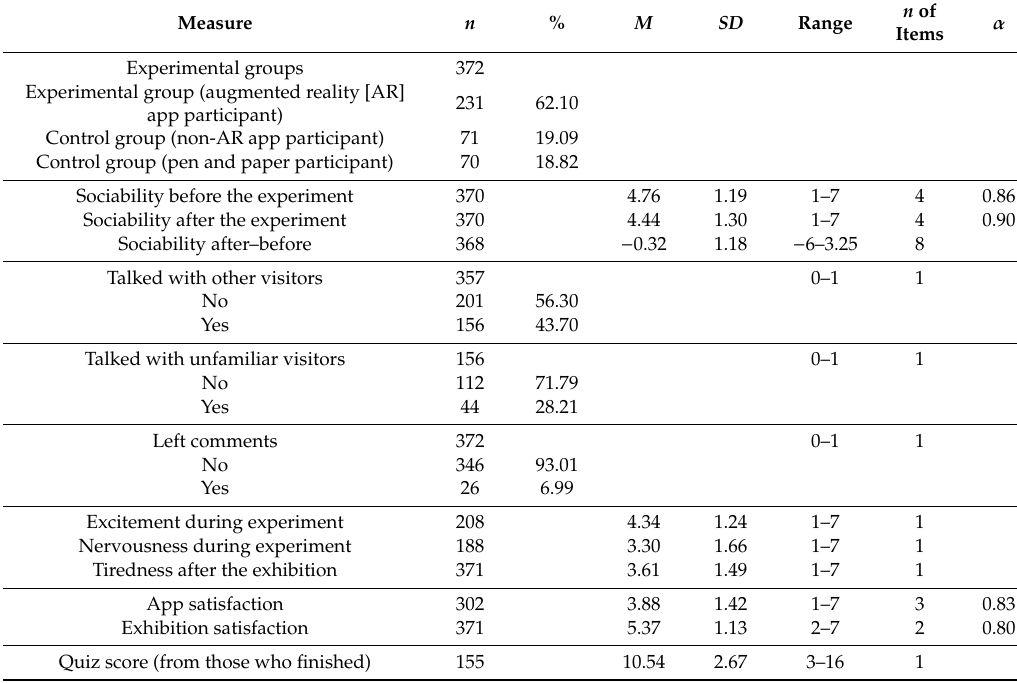
Table 1. Summary of Descriptive Statistics of the Study Variables ( N = 372): Frequency ( n ), Percent (%), Mean ( M ), Standard Deviation ( SD ), Range, Number of Items in a Sum Variable, and Alpha ( α ). Measure n % M SD Range